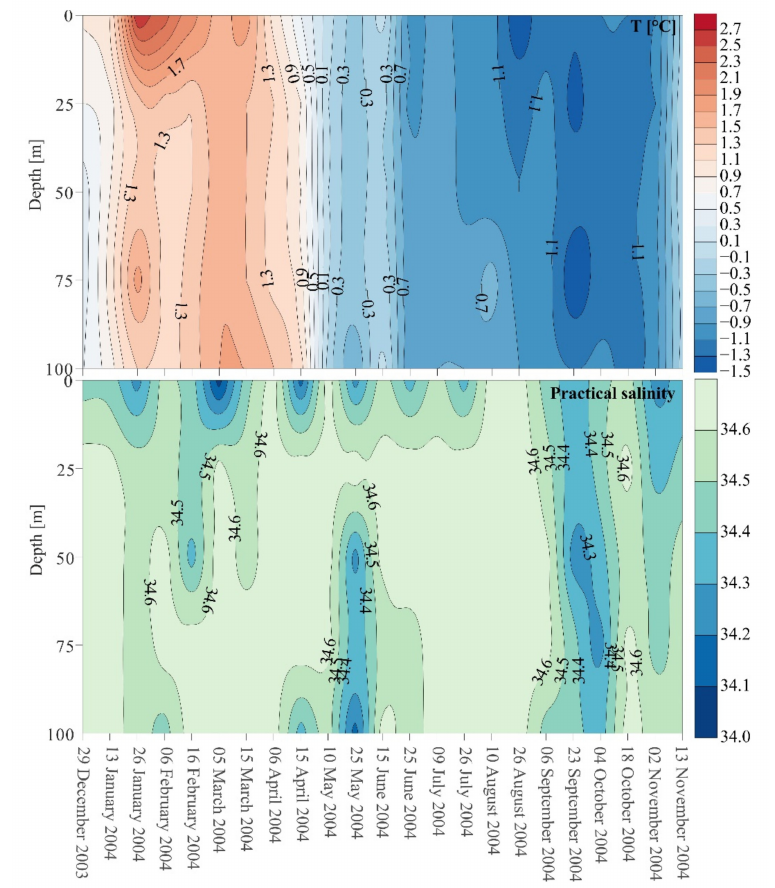
Figure 2. Variabilities in temperature (T) ( ◦ C) and salinity, in the surface water layer (50–0 m) and in the intermediate water layer (100–50 m) of Admiralty Bay from December 2003 to November